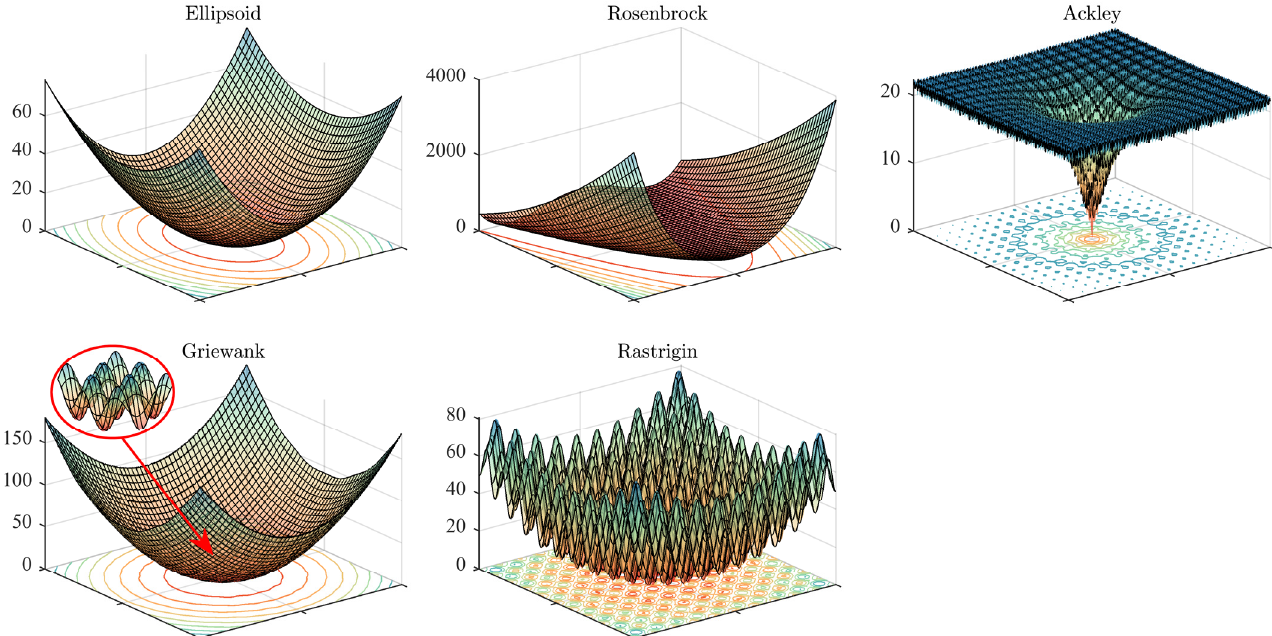
Figure 4. The landscape graphs of the benchmark problems.